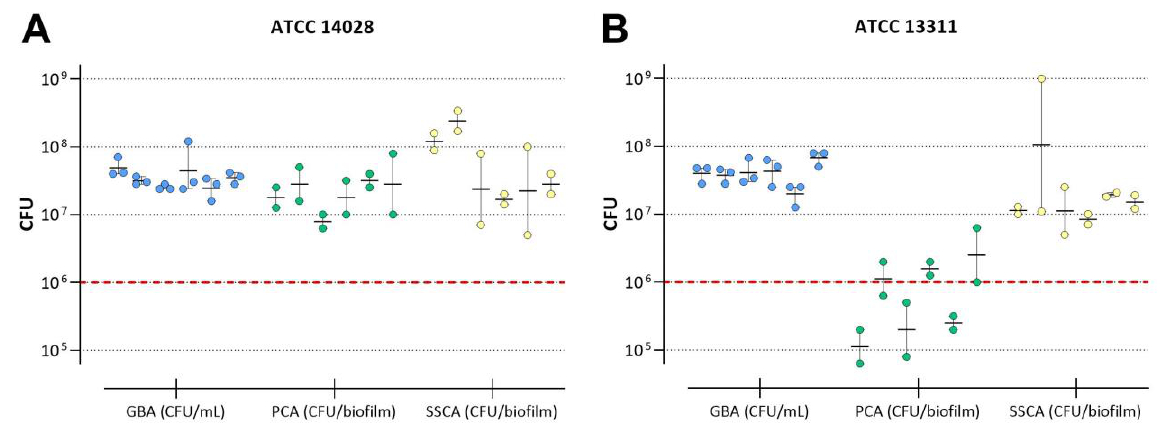
Figure 2. Recovered numbers of viable cells of untreated ATCC 14028 ( A ) and ATCC 13311 ( B ) biofilms given in CFU/mL (GBA, blue) or CFU/biofilm (PCA, green, and SSCA, yellow), respectively. Presented here are the mean CFU/mL or biofilm (horizontal lines) as well as individual values of at least two technical replicates of six experiments performed by the same technician. Colored bullets represent individual biofilm replicates. Dashed red lines indicate the desired minimal cell number of 10 6 CFU.